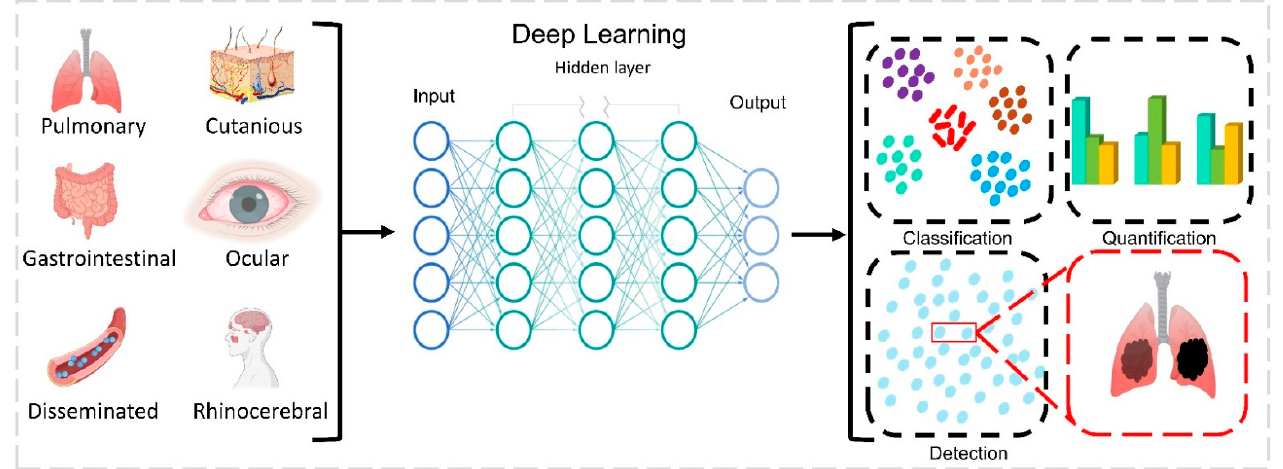
Figure 5. Mucormycosis infections of various types are associated with COVID-19.